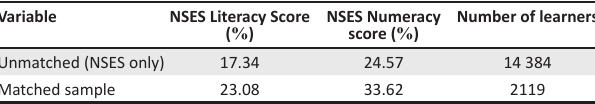
TABLE 2: Taylor and Taylor’s comparison between the matched (SE and NSES) and unmatched (NSES only) samples (reproduced verbatim).